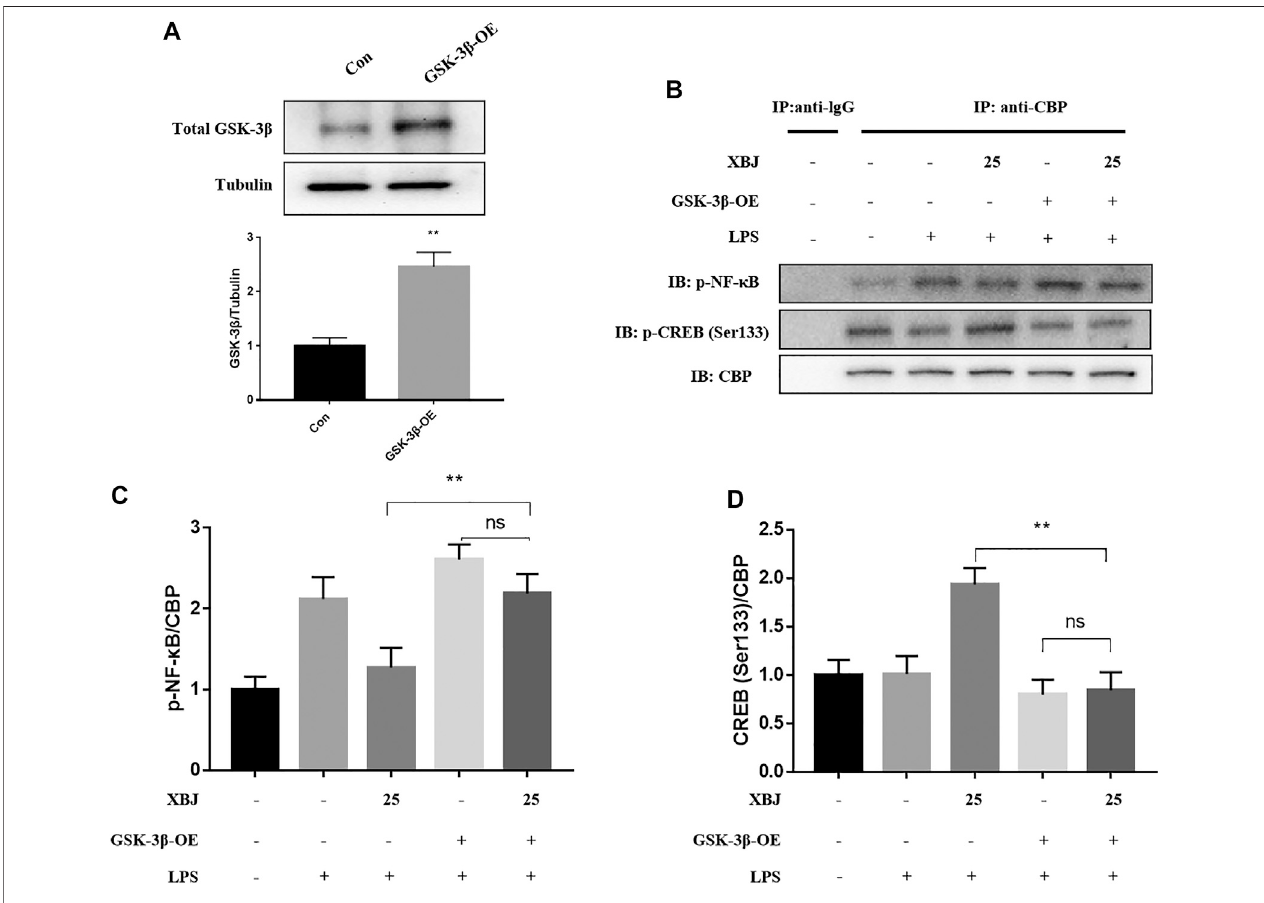
FIGURE 8 | Overxepression of GSK-3 β regulates the expression pNF- κ B and CREB (Ser133) (A) GSK-3 β was successfully overexpressed in cells. (B) Representative immunoblotsofp-NF- κ Band p-CREB (C) GSK-3 β -OE increased theexpression ofpNF- κ Bincells. (D) GSK-3 β -OE decreased theexpression ofCREB in cells. Con: control group; GSK-3 β -OE: GSK-3 β overexpression group. * p < 0.05, ** p < 0.01 were considered to be signi fi cant. Data are expressed as mean ± SD.